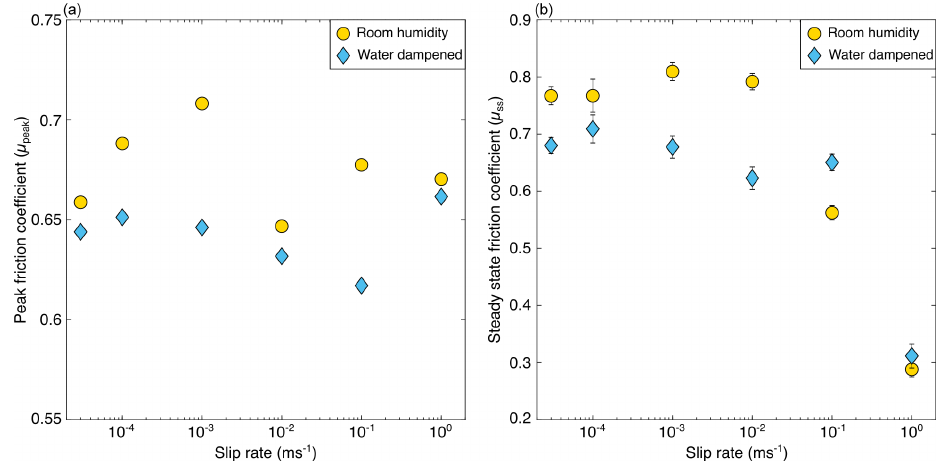
Figure 3. Peak and steady-state friction coefficients. (a) For experiments that showed slip strengthening, the peak friction coefficient was calculated just before the onset of strengthening behaviour in the first 0.1m of slip. For experiments showing dynamic weakening, the peak friction immediately precedes the friction drop (see Fig. 2b and d). (b) Steady-state friction coefficient was calculated at displacements between 0.15 and 0.35m.